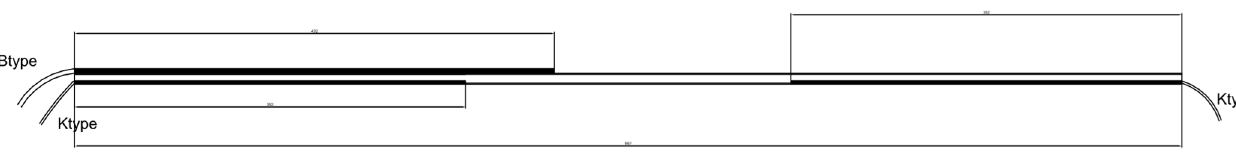
Figure 2. Overall dimensioned view of receiver with thermocouples.